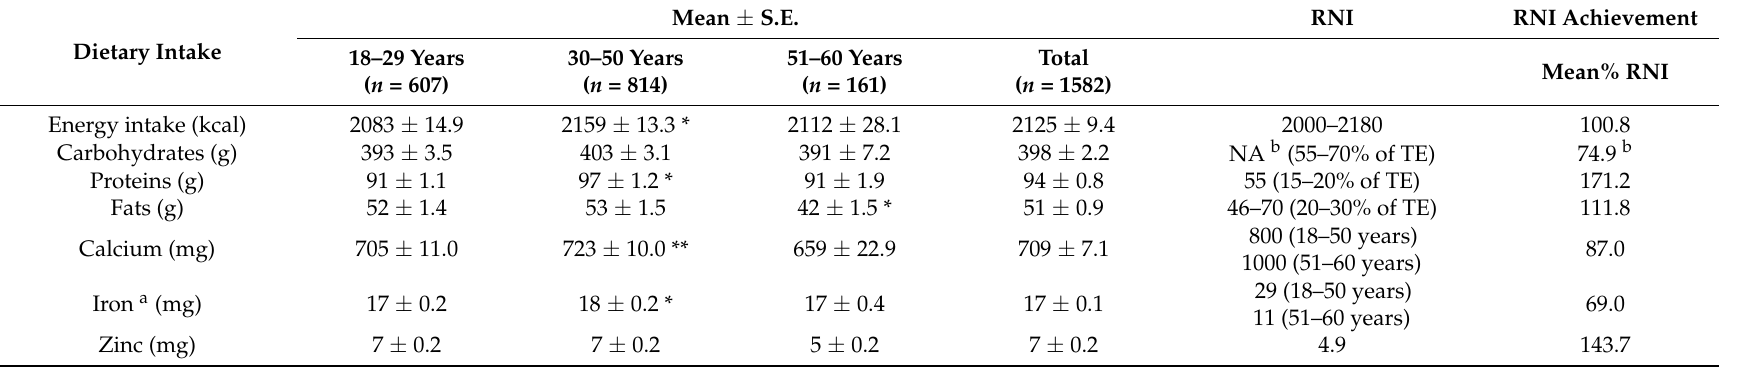
Table 3. Nutrient intake of women in a day by age groups and comparing nutrient intake with Recommended Nutrient Intake